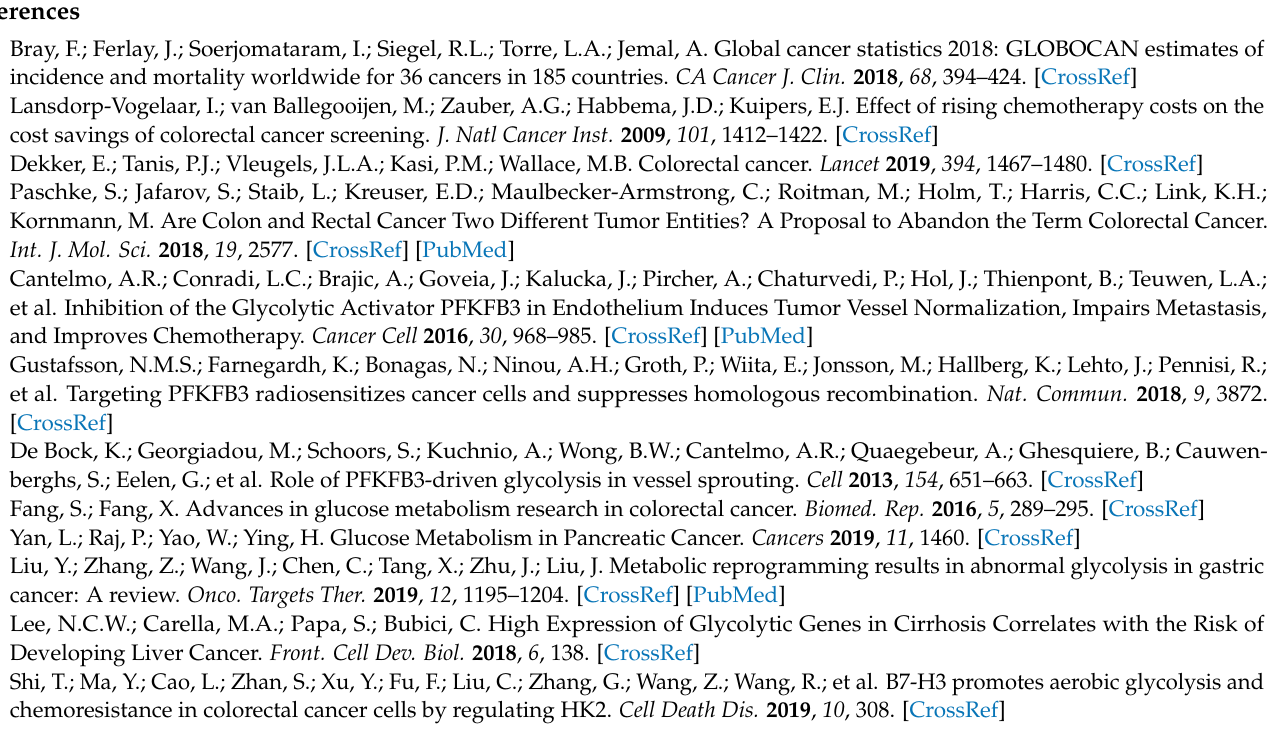
Figure S4: (A–D) Additional experimental repetitions of RT-PCR analysis for migration-related genes performed with HUVEC cells after 12, 24 and 48 h treatment with